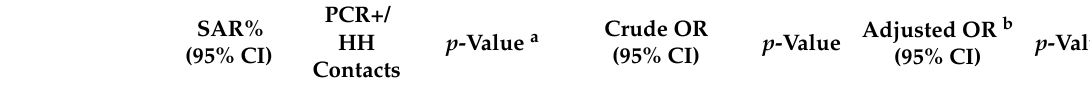
Table 5. Effect of behavioral factors and precautionary practices on secondary attack rate